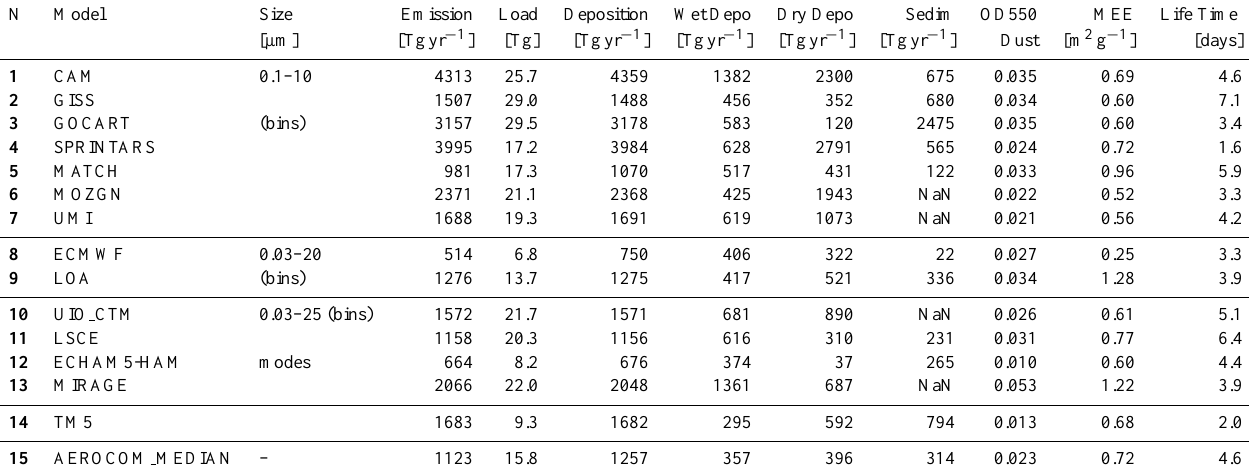
Table 3. Mass balance for each one of the models. NaN represents variables not provided by model. MEE corresponds to the mass extinction